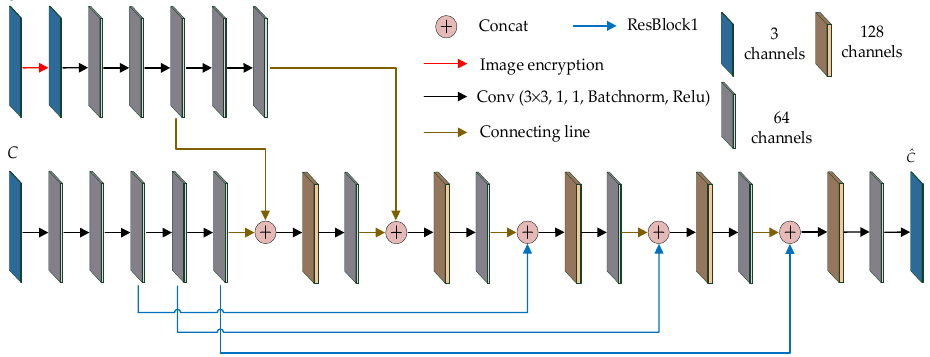
Figure 3. Hiding network structure (Conv: Convolutional network, Concat: Concatenation operation).